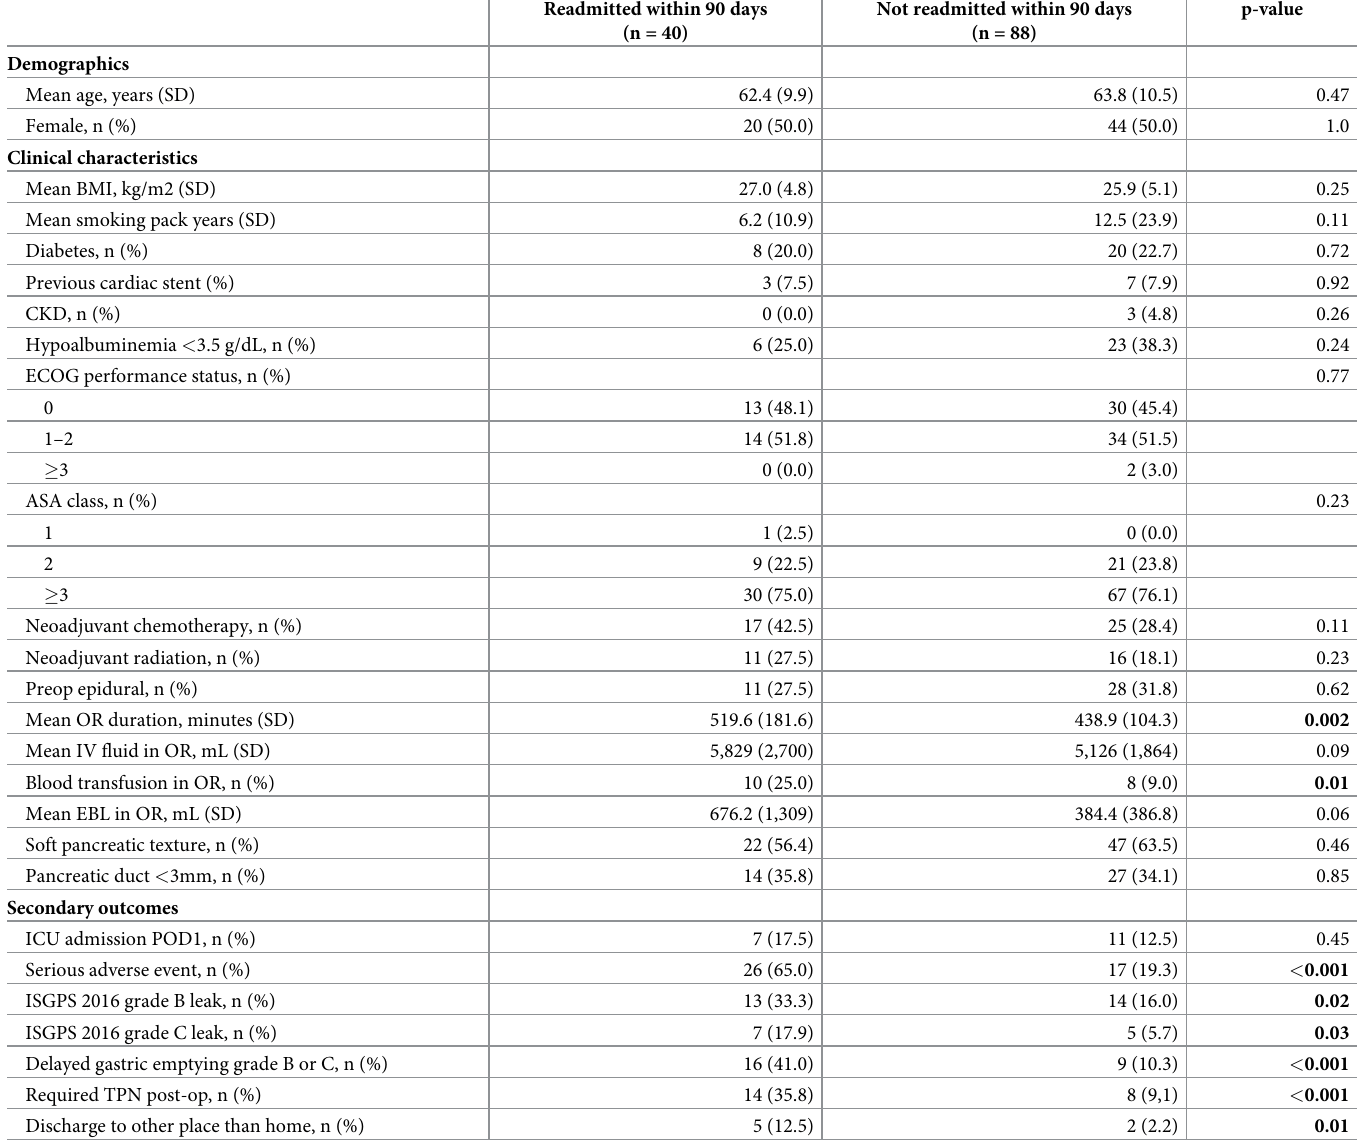
Table 4. Demographics, clinical characteristics, and outcomes of patients readmitted within 90 days of